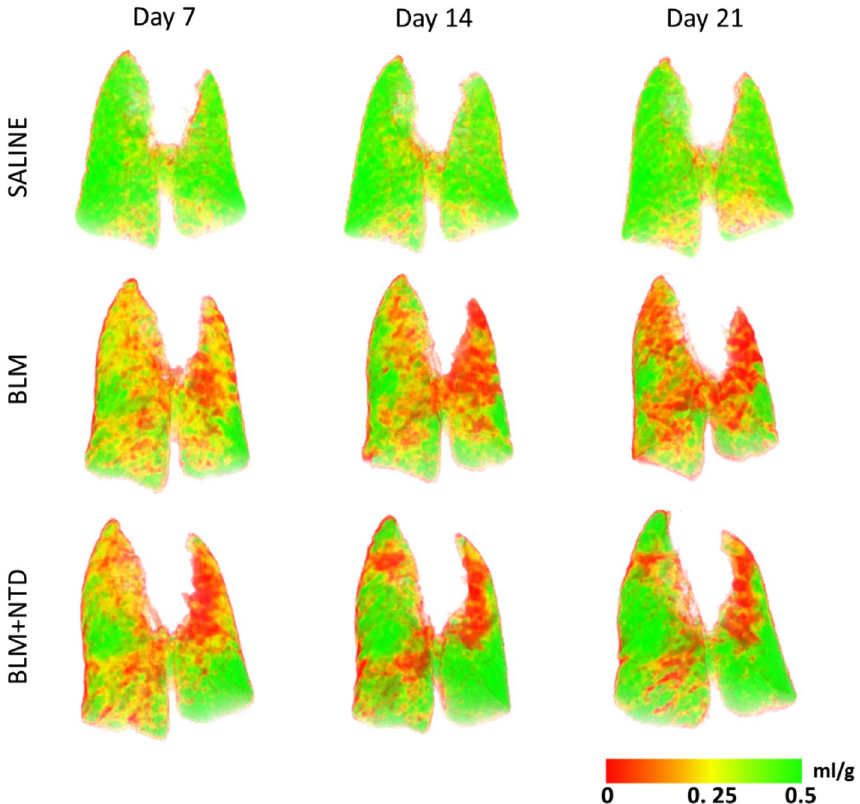
Figure 4. Ventilation maps in a saline (top) and a representative BLM (middle) and BLM + NTD (bottom) animal at all timepoints. Color scale indicates the SVg difference between the inspiratory and the expiratory lung images (ml of air to grams of tissue). In the saline the ventilation map is homogeneously coloured in green (about 0.4 ml/g). In the BLM animal, at day 7, an overall decrease of ventilation was present in the overall lungs (about 0.2 ml/g), which progressed in the following timepoints, with apical regions at day 21 not ventilated. In the BLM + NTD animal, ventilation decreased similarly to the BLM at day 7, but was partially recovered at day 14, remaining stable at day